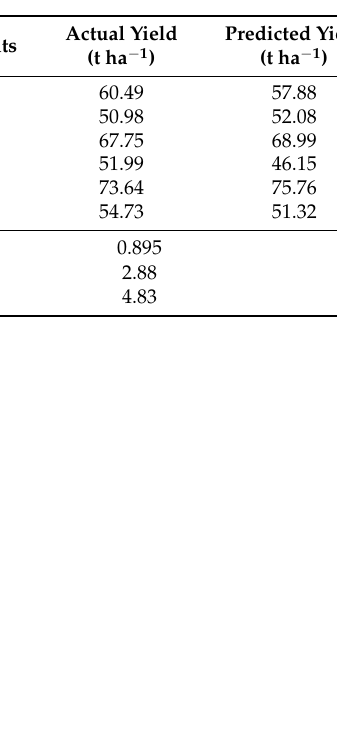
Figure 2. Water sensitive index accumulation curve. Table 5. The measured and predicted crop yield of tomato.